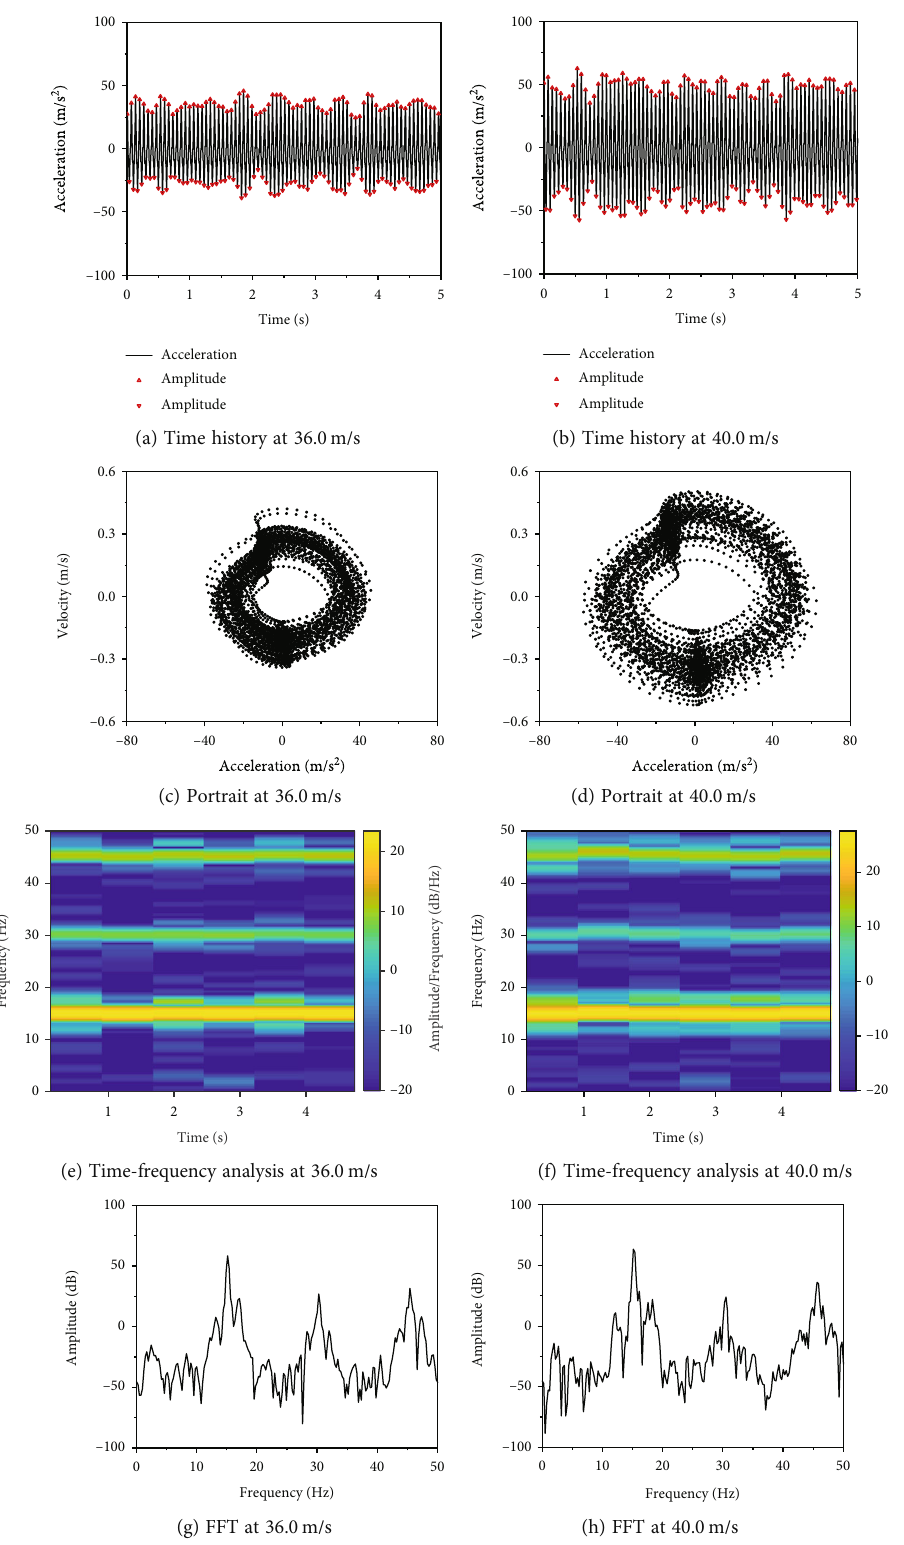
Figure 22: Nonlinear LCO test results at the trailing edge of aileron (accelerometer